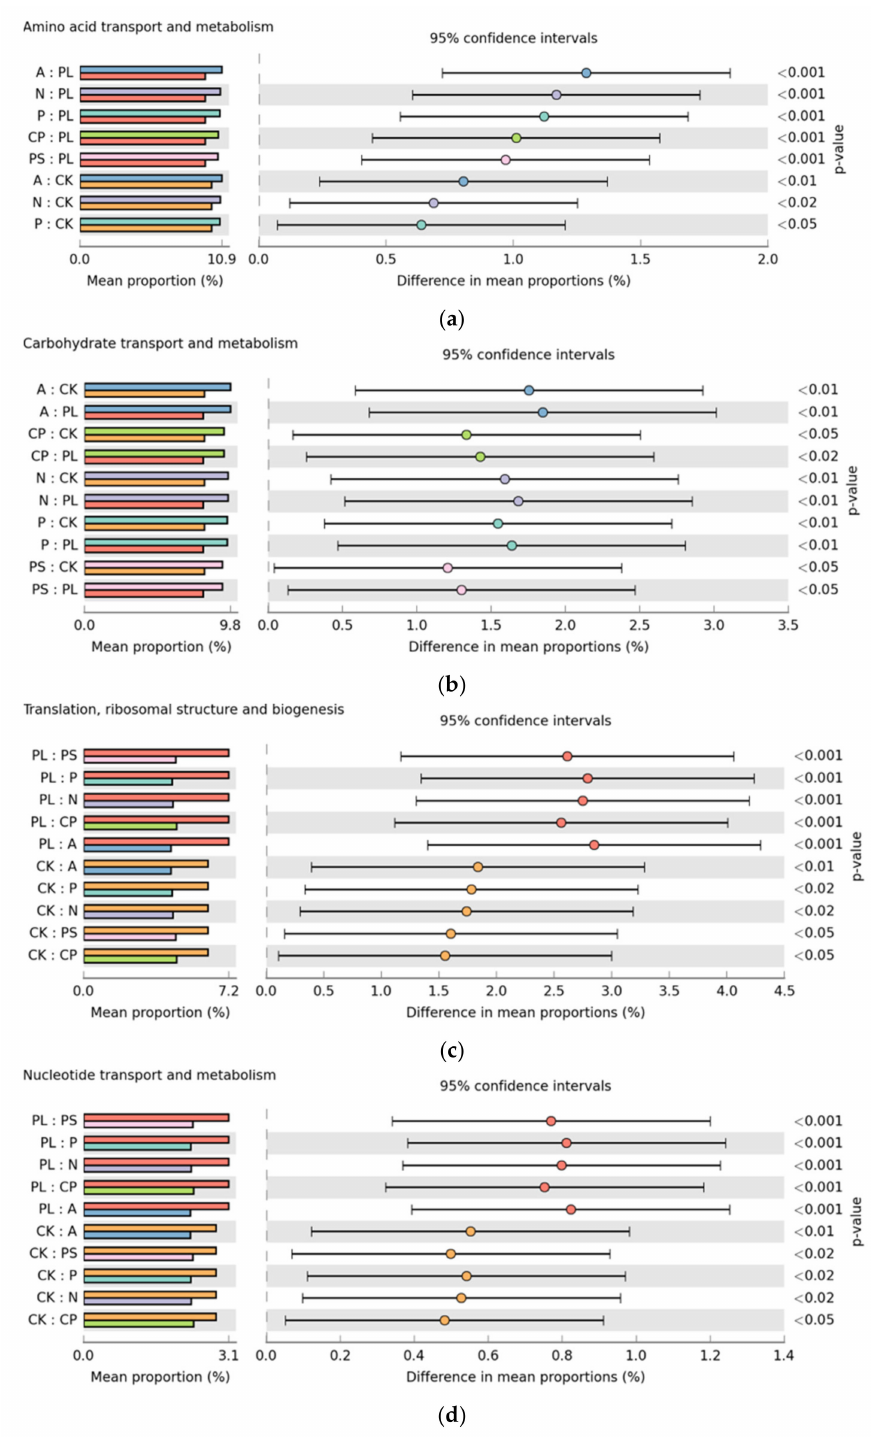
Figure 9. Significant differences (one-way ANOVA, Tukey–Kramer post-hoc test, p < 0.05.) in functions abundance of ( a ) Amino acid transport and metabolism, ( b ) Carbohydrate transport and metabolism, ( c ) Translation, ribosomal structure and biogenesis and ( d ) Nucleotide transport and